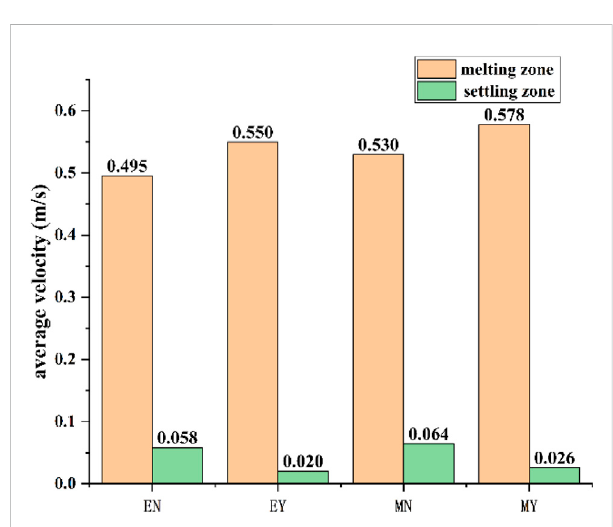
FIGURE 11 Comparison of average body velocity in melting zone and settling zone at 3 s in four